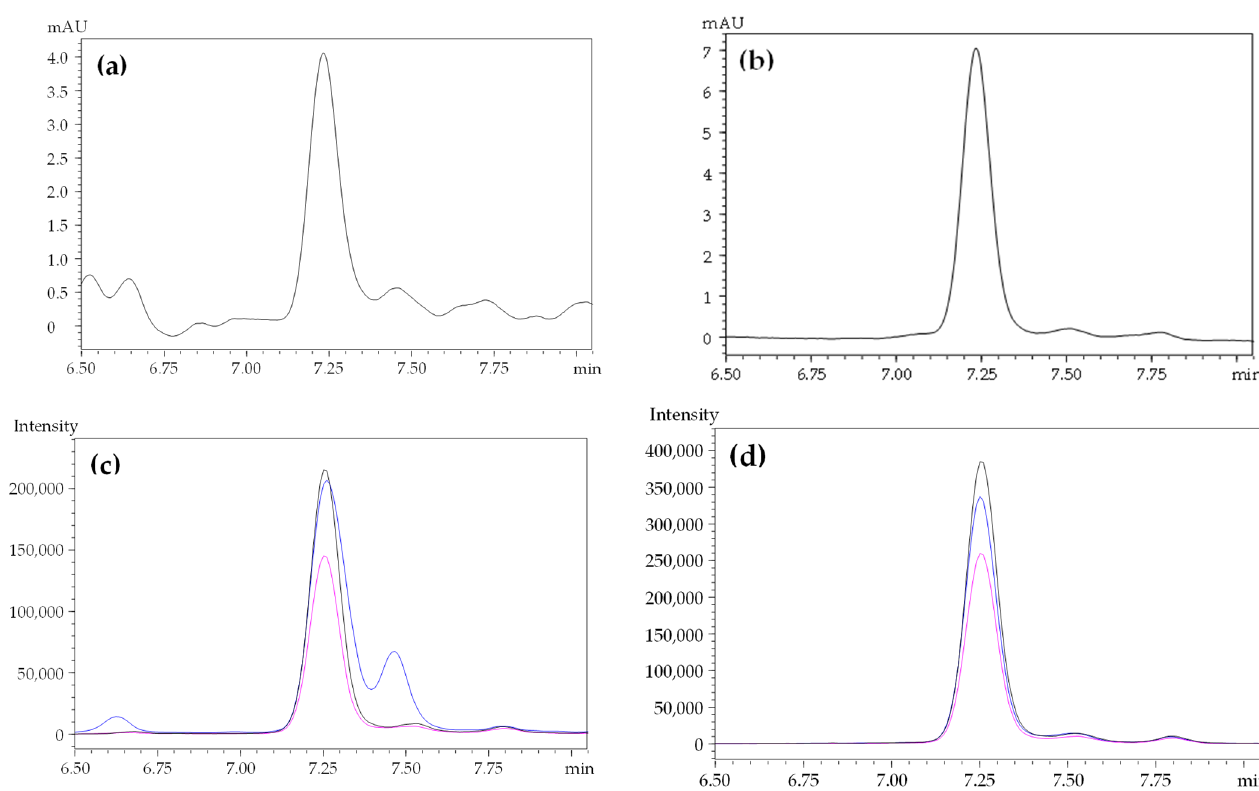
Figure 3. Comparisons of the UV chromatograms and MS/MS profiles of ELE and the purified oenothein B ( 1 ). ( a , c ), ELE; ( b , d ), purified compound 1 . ( a , b ) show HPLC chromatograms recorded at 270 nm. ( c , d ) show MS/MS profiles in the negative ion mode at m / z 765.00 (black), 300.85 (blue), and 275.00 (pink).